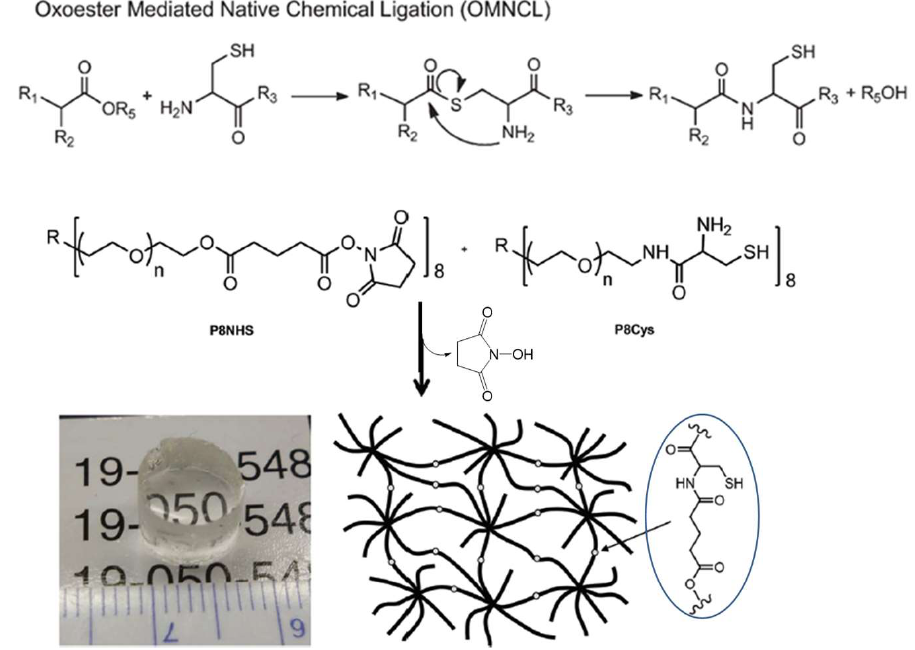
Figure 10. A generalized reaction scheme for oxo-ester-mediated native chemical ligation (OMNCL) used for crosslinking eight-armed PEG macromonomers to form a chemical hydrogel network. Image reproduced with permission from [53]. Copyright 2013 RSC.